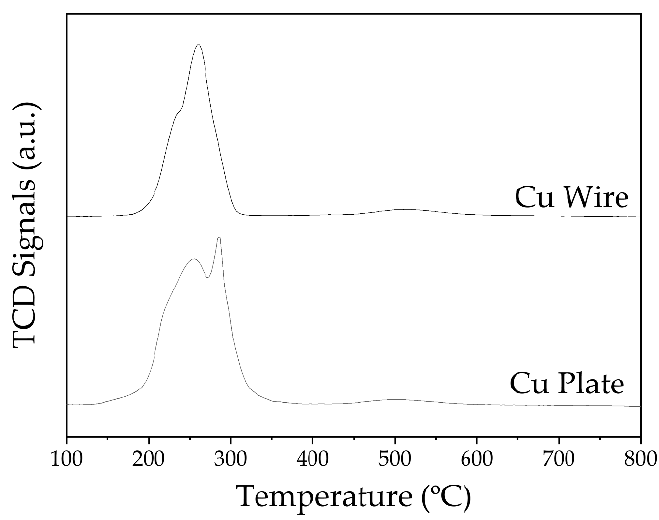
Figure 3. TPR profiles of Cu Wire and the Cu Plate. 10 ◦ C/min. Finally, the reduction of CuO to Cu 2 O with H 2 (10 mL/min) took place at 200 ◦ C for 30 min. The aim of this last step was to reduce the copper (+2) oxide species to copper (+1) according to the results of TPR. Figure 4 shows the XRD profile of Cu wire and the Cu plate before and after pre-treatment.